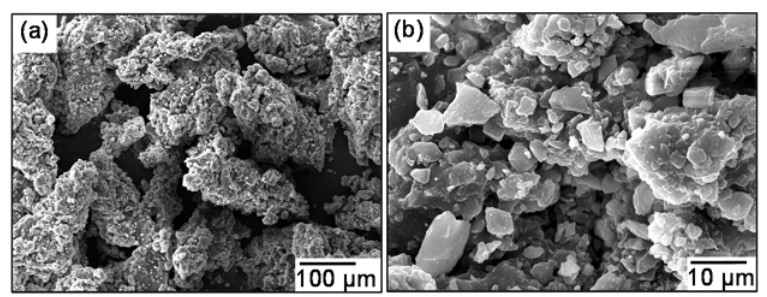
Figure 11. Micro-morphology images of crumb rubber particles: ( a ) under low magnification times; ( b ) under high magnification times. ( b ) under high magnification times.